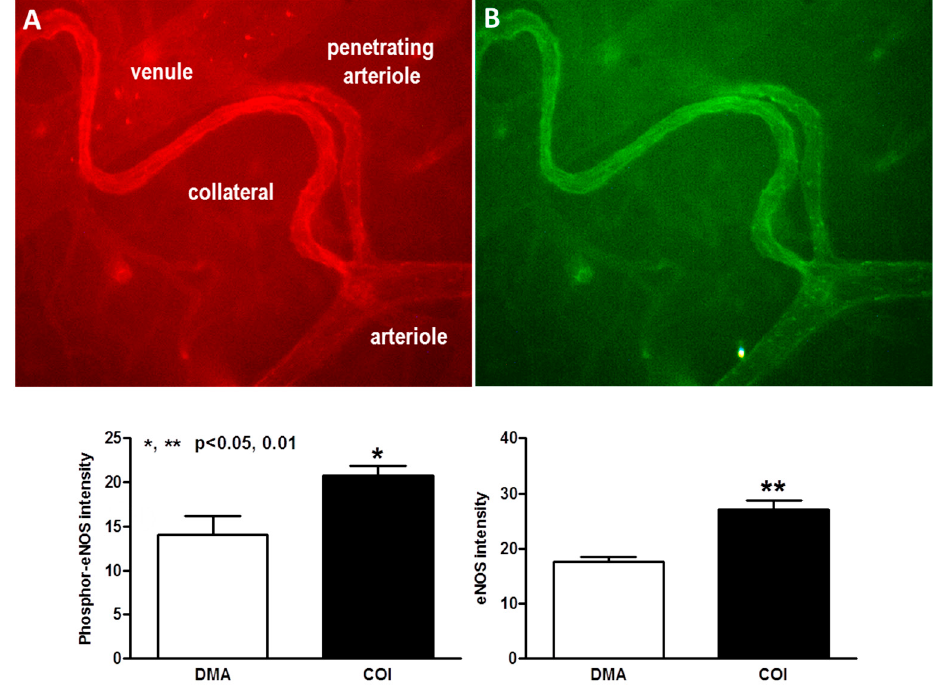
Figure 7. Collaterals express increased levels of phospho- and total eNOS compared to arterioles. Top panels, immunohistochemistry for phospho- ( A , red) and total ( B , green) eNOS, n = 4 mice, 1-sided t-tests, 163x magnification. * p < 0.05, ** p < 0.01.